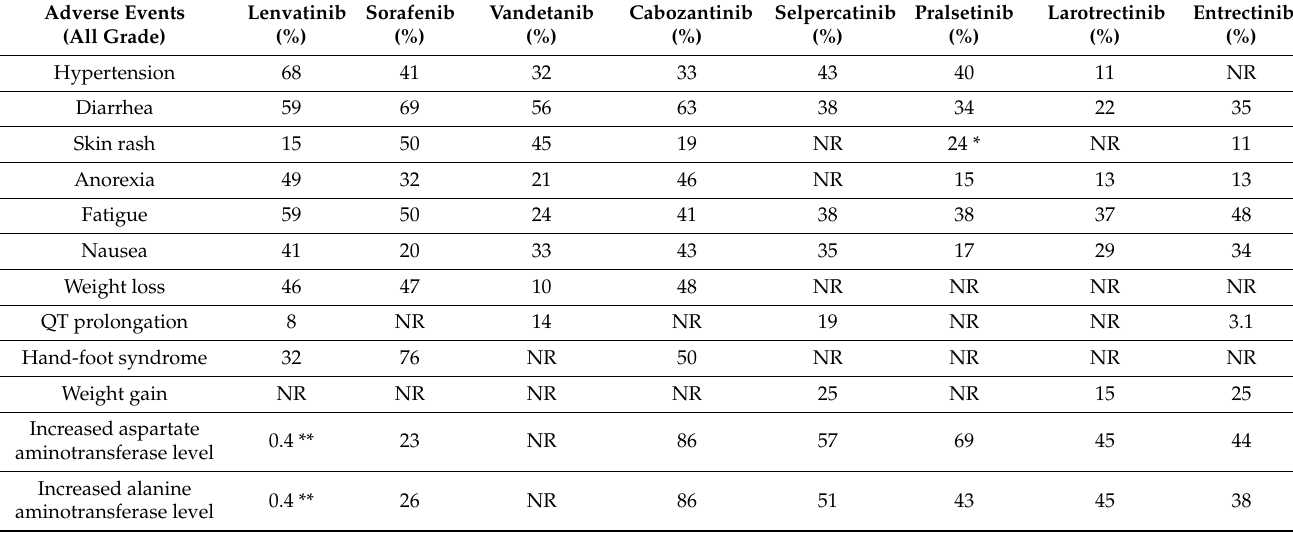
Table 2. More frequent adverse events reported for the currently available tyrosine kinase